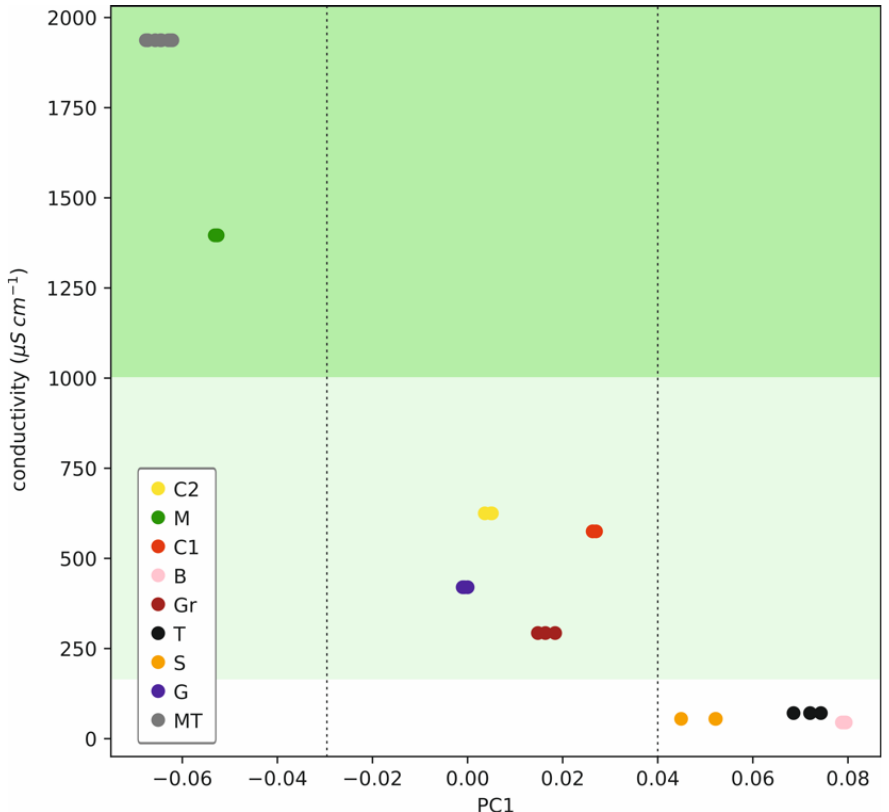
Figure 8. Plot of the conductivity of each sample versus PC1 for the pool of samples and including the three MT repetitions along the analysis. Regions are distinguished for high (dark green), medium (light green) and low sample conductivity.